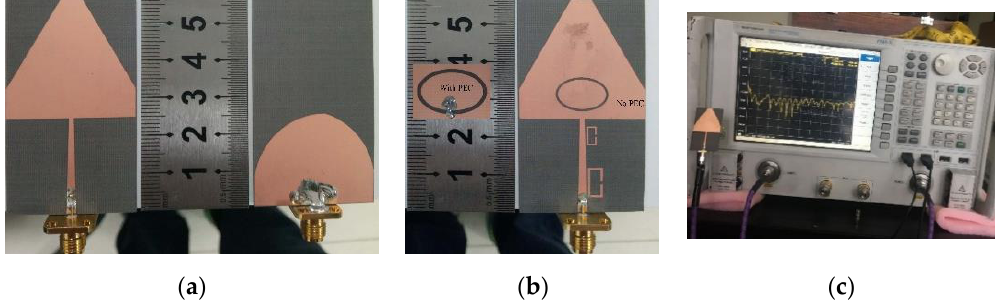
Figure 4. The fabricated prototype: ( a ) Top side and back side of without notch; ( b ) top side of band notch of SWB antenna; and ( c ) a photograph of measuring device.